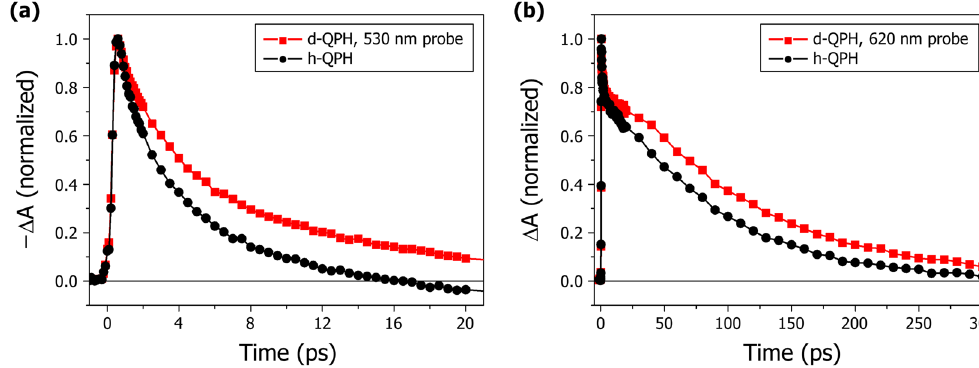
Figure 4. Comparison of time profiles between deuterium substituted QPH and unsubstituted QPH at the probe wavelength of ( a ) 530 nm and ( b ) 620